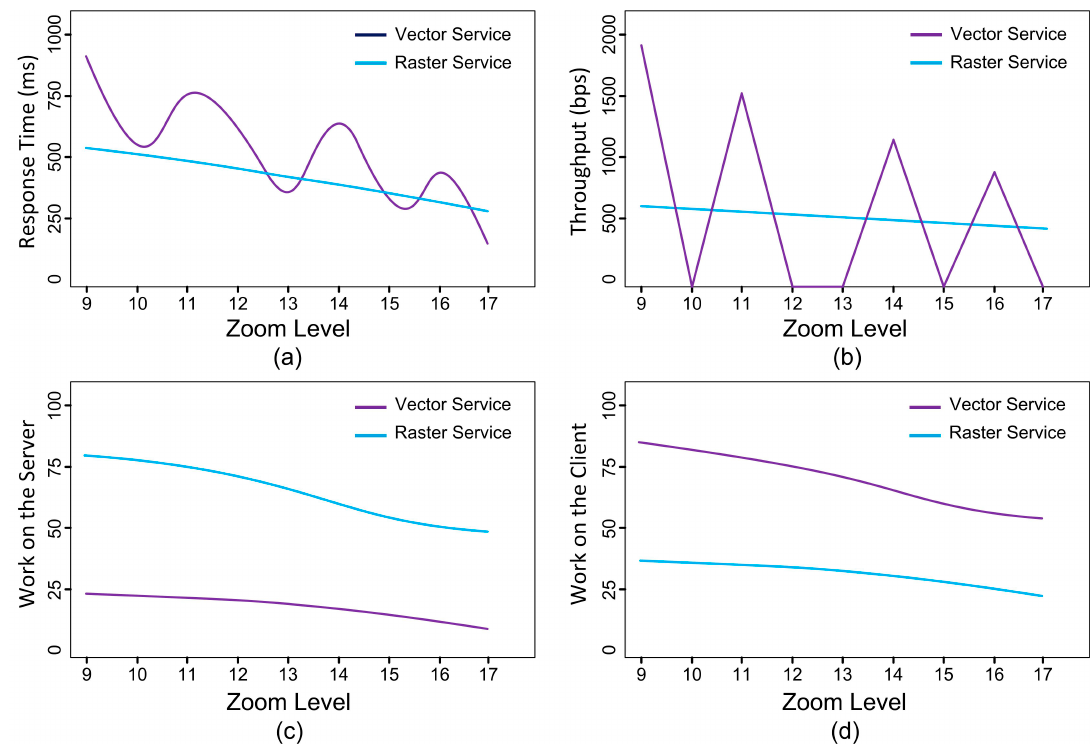
Figure 24. The performance of two map service patterns: ( a ) the total response time for the map display based on vector tiles service and raster tiles service; ( b ) the data throughput for vector tiles and raster tiles; ( c ) the amount of processing work on the server side; ( d ) the amount of processing work on the client side.